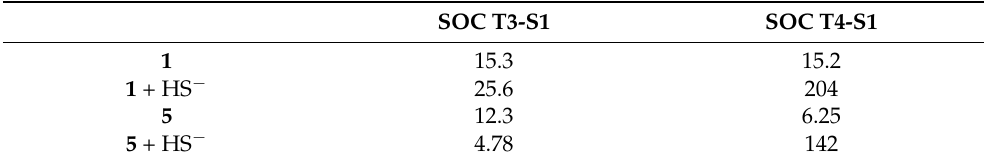
Figure 4. Computed energies ( E , eV) of the ground state (S 0 ) first excited singlet (S 1 ) and four lowest energy triplet states, evaluated at the S 1 geometry for complex 1 and 5 , and their HS − adducts. Table 2. Spin-Orbit coupling elements (cm − 1 ) for 1 , 5 and their Concerning complex 1 , the exoergonic S 1 → T 3 transition is slightly more favored after HS − coordination, as demonstrated by the higher spin-orbit coupling (SOC) and the lower